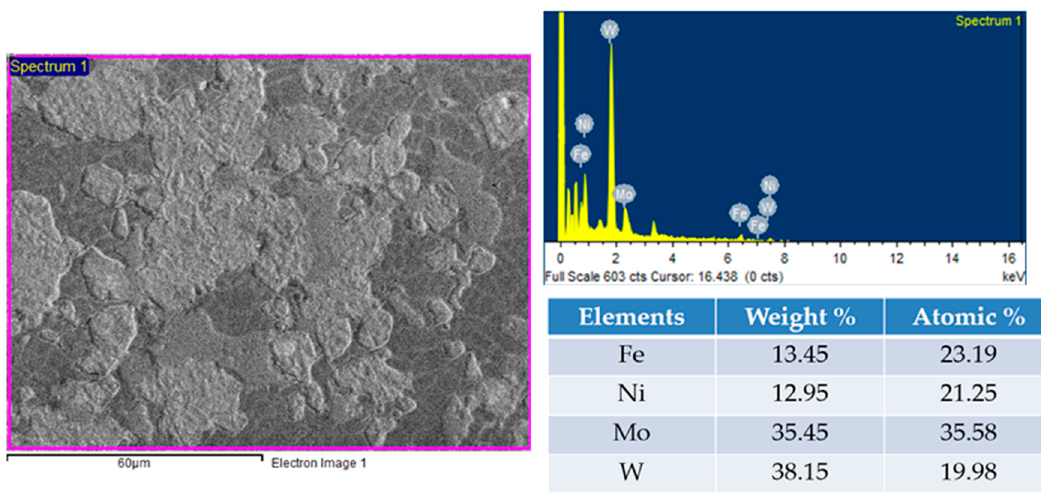
Figure 3. Energy dispersive X-ray spectroscopy of the 45W-7Ni-3Fe-45Mo alloy.